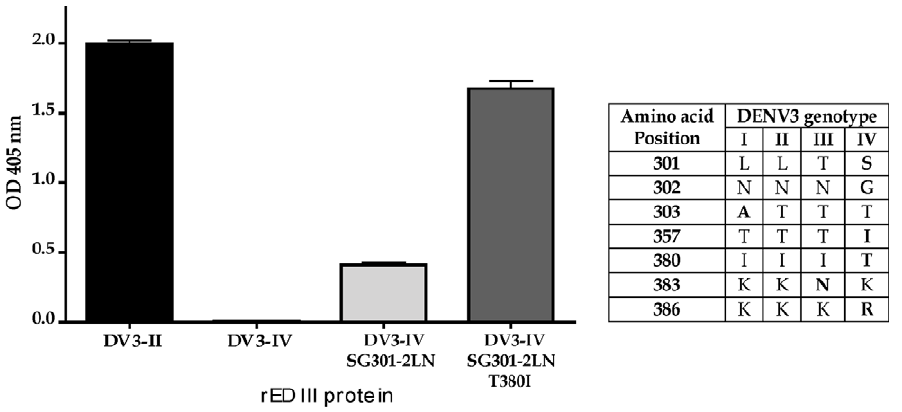
Figure 7. Identification of naturally occurring mutations that reduce binding of MAb 8A1. The table displays the EDIII amino acid differences between the different genotypes of DENV3. MAb 8A1 bound to EDIII from DENV3 genotype II (DV3-II) but not genotype IV (DV3-IV). Binding was partially restored when positions 301 and 302 were changed from the genotype IV to genotype II (DV3-IV SG301-2LN)). Complete binding was restored when positions 301, 302 and 380 were changed (DV3-IV SG301-2LN, T380I).